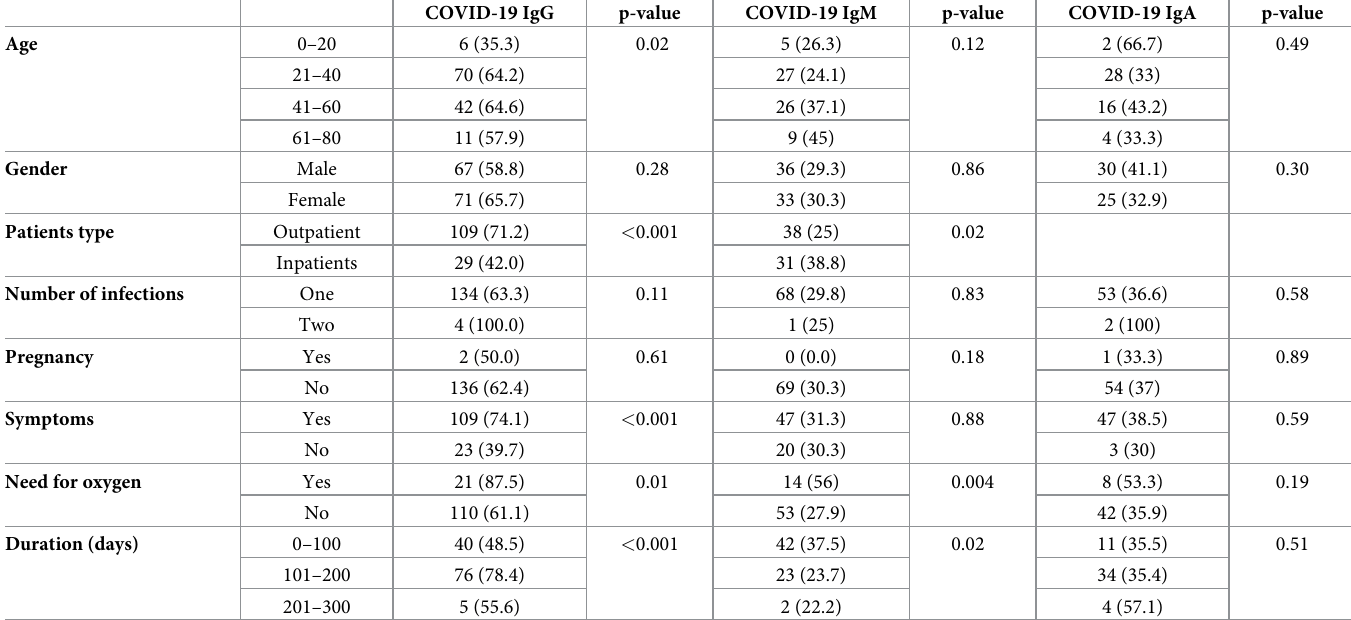
Table 3. Association of COVID-19 IgG, IgM, and IgA among COVID-19 patients with demographic and clinical data (n = 233).